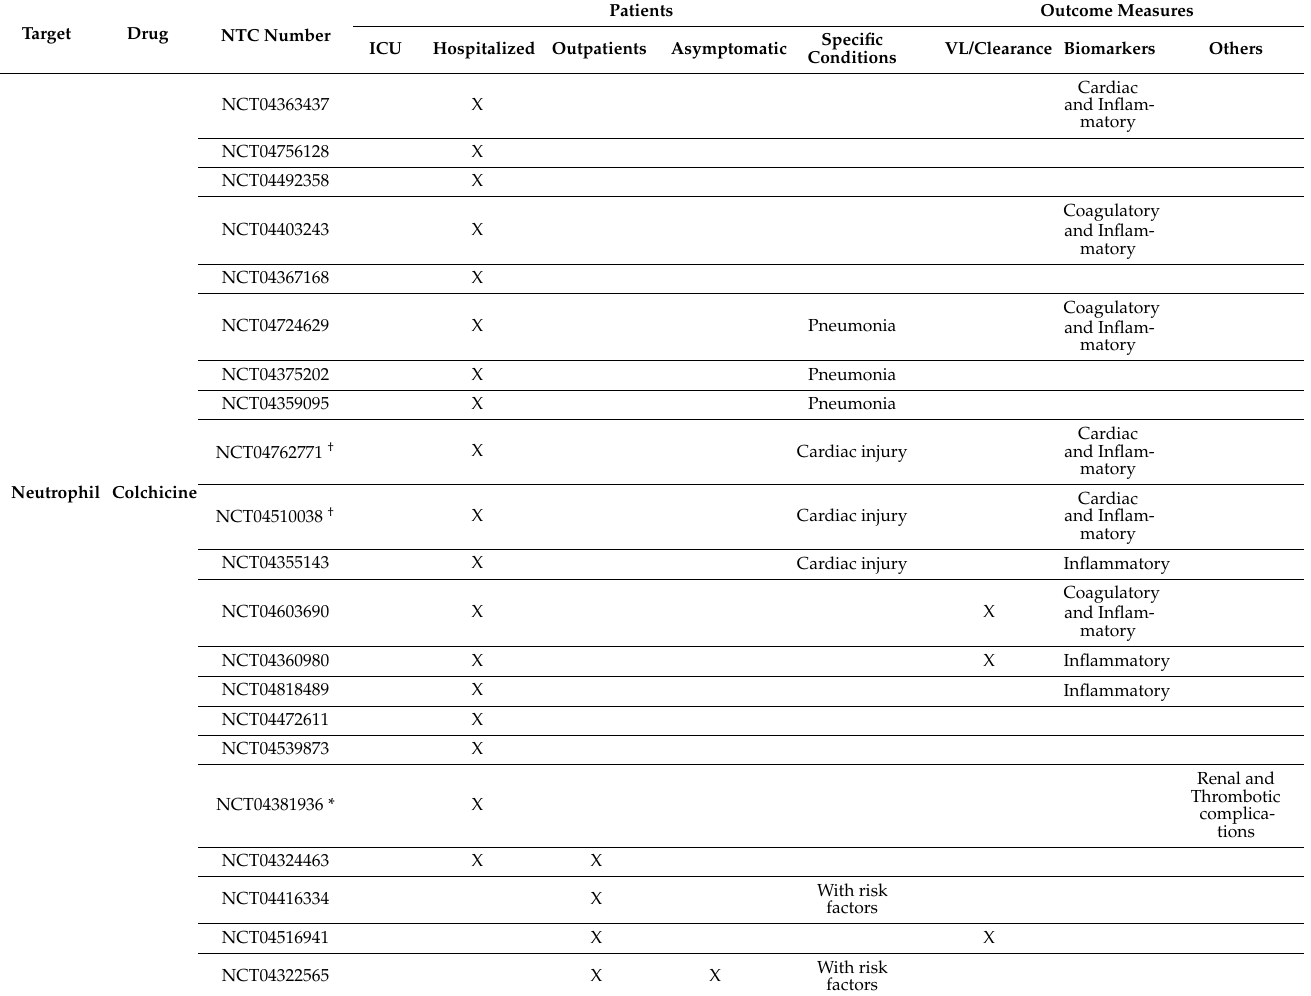
Table 2. Ongoing clinical trials in COVID-19 patients with drugs that target a phase of the process of neutrophil extracellular trap (NETs)